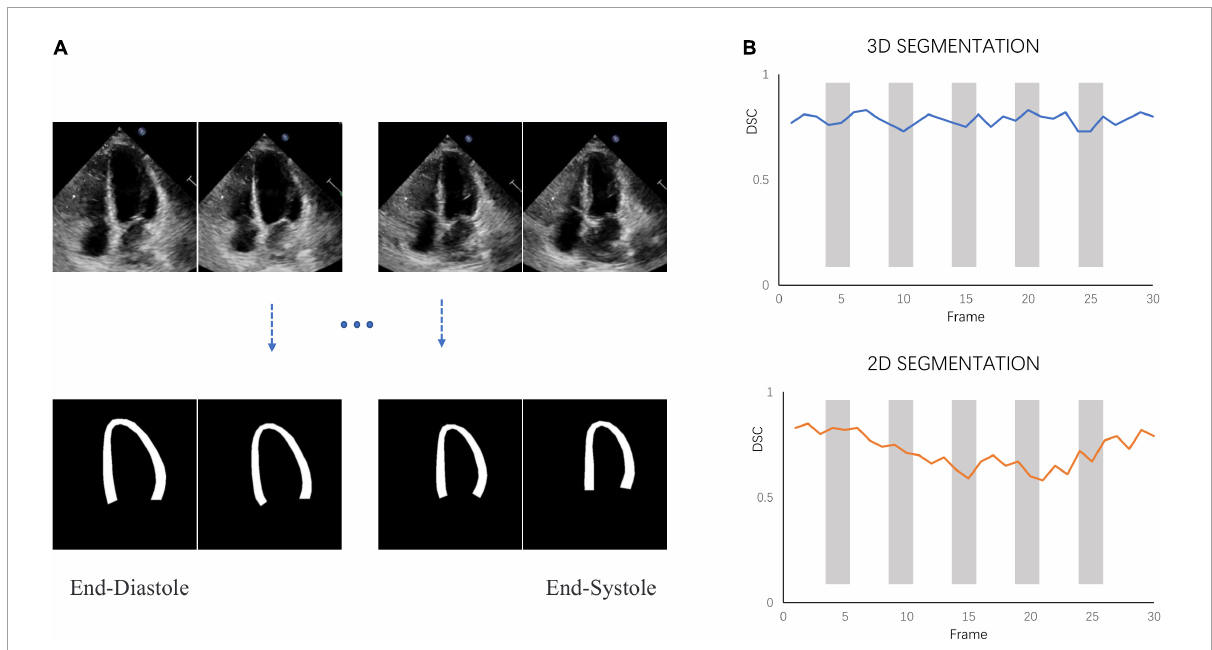
FIGURE4 Segmentation performance. (A) 3D-CSN allows simultaneous segmentation of multiple frames. Inputting echocardiogram video sequence frames (top row) will generate corresponding segmentation masks (bottom row). (B) The dice similarity coefficient (DSC) was calculated for each frame of video on different models.